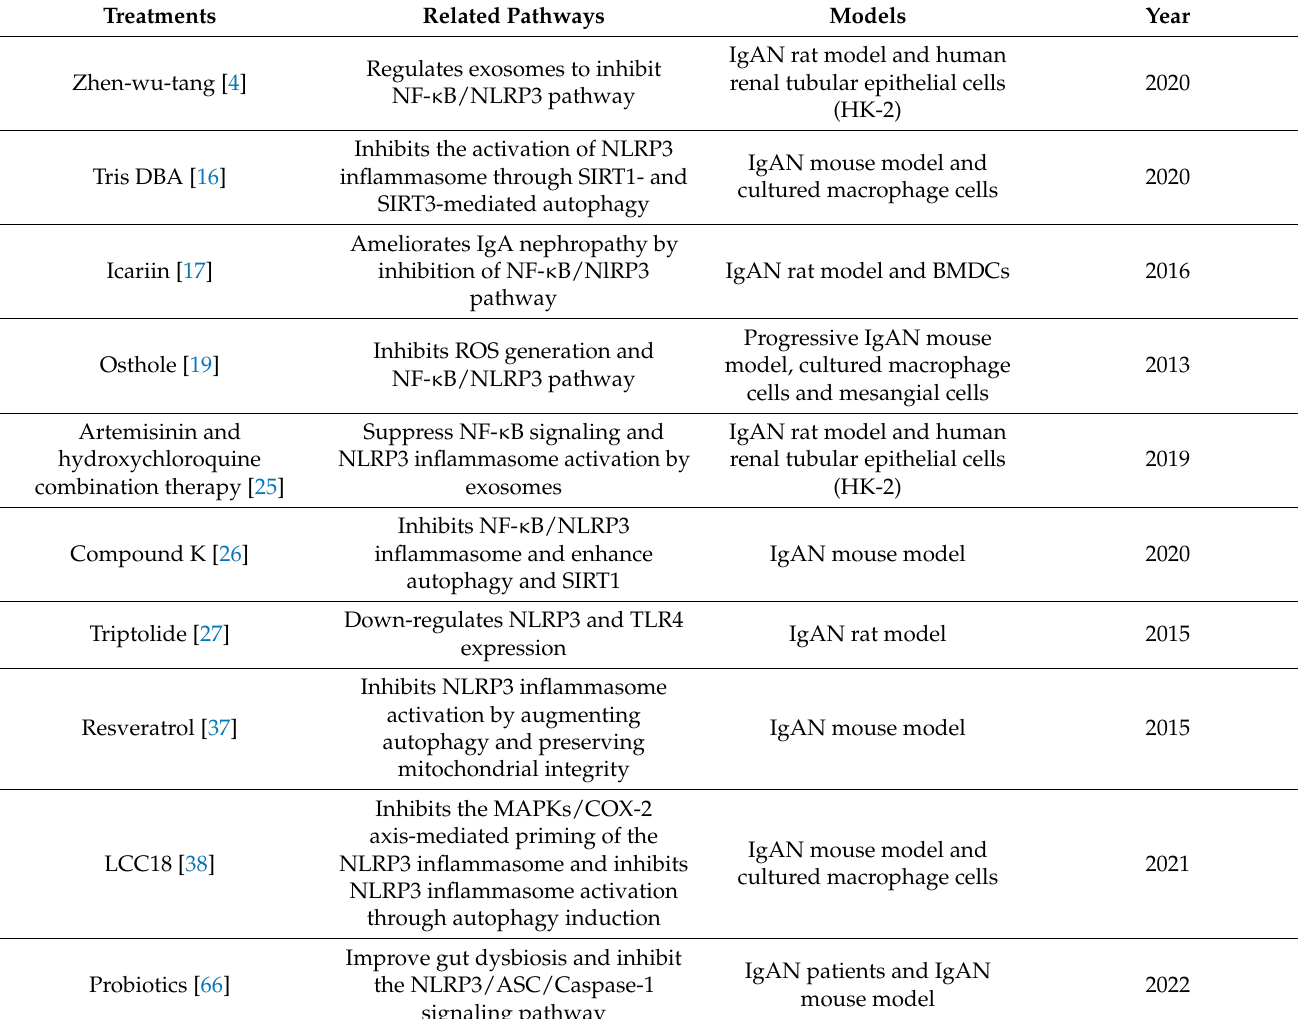
Table 1. Studies about treatments related to pathways between IgAN and NLRP3